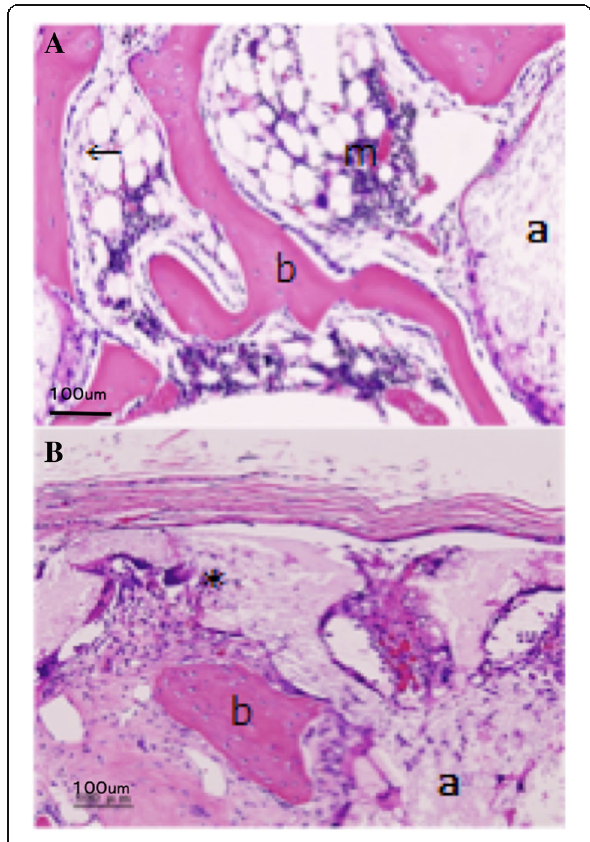
Fig. 4 Histological (magnified image). A u-HA/PDLLA + types 1 and 3 collagen. B u-HA/PDLLA. a, material; b, newly formed bone; ← , osteoblast; m, bone marrow cell; *, foreign body giant